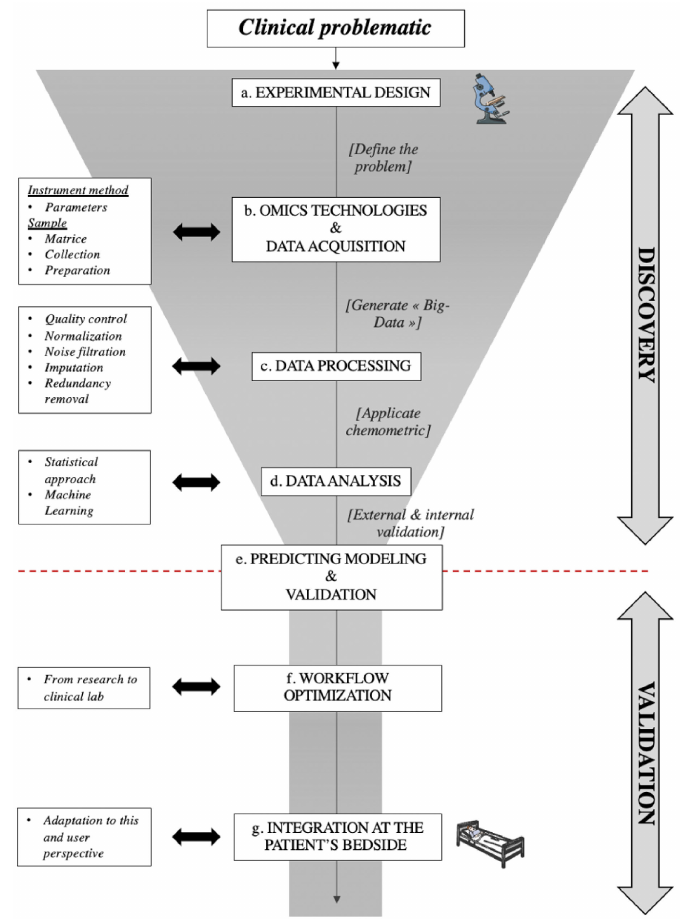
Figure 1. Toward an optimized use of omics in clinical application: workflow, advantages, and limits. The workflow is divided into two sections: Discovery (I) and Validation (II), which in turn are divided into several steps. All steps are described in the section, “Toward an optimized use of omics in clinical application: workflow, advantages, and limits” of the